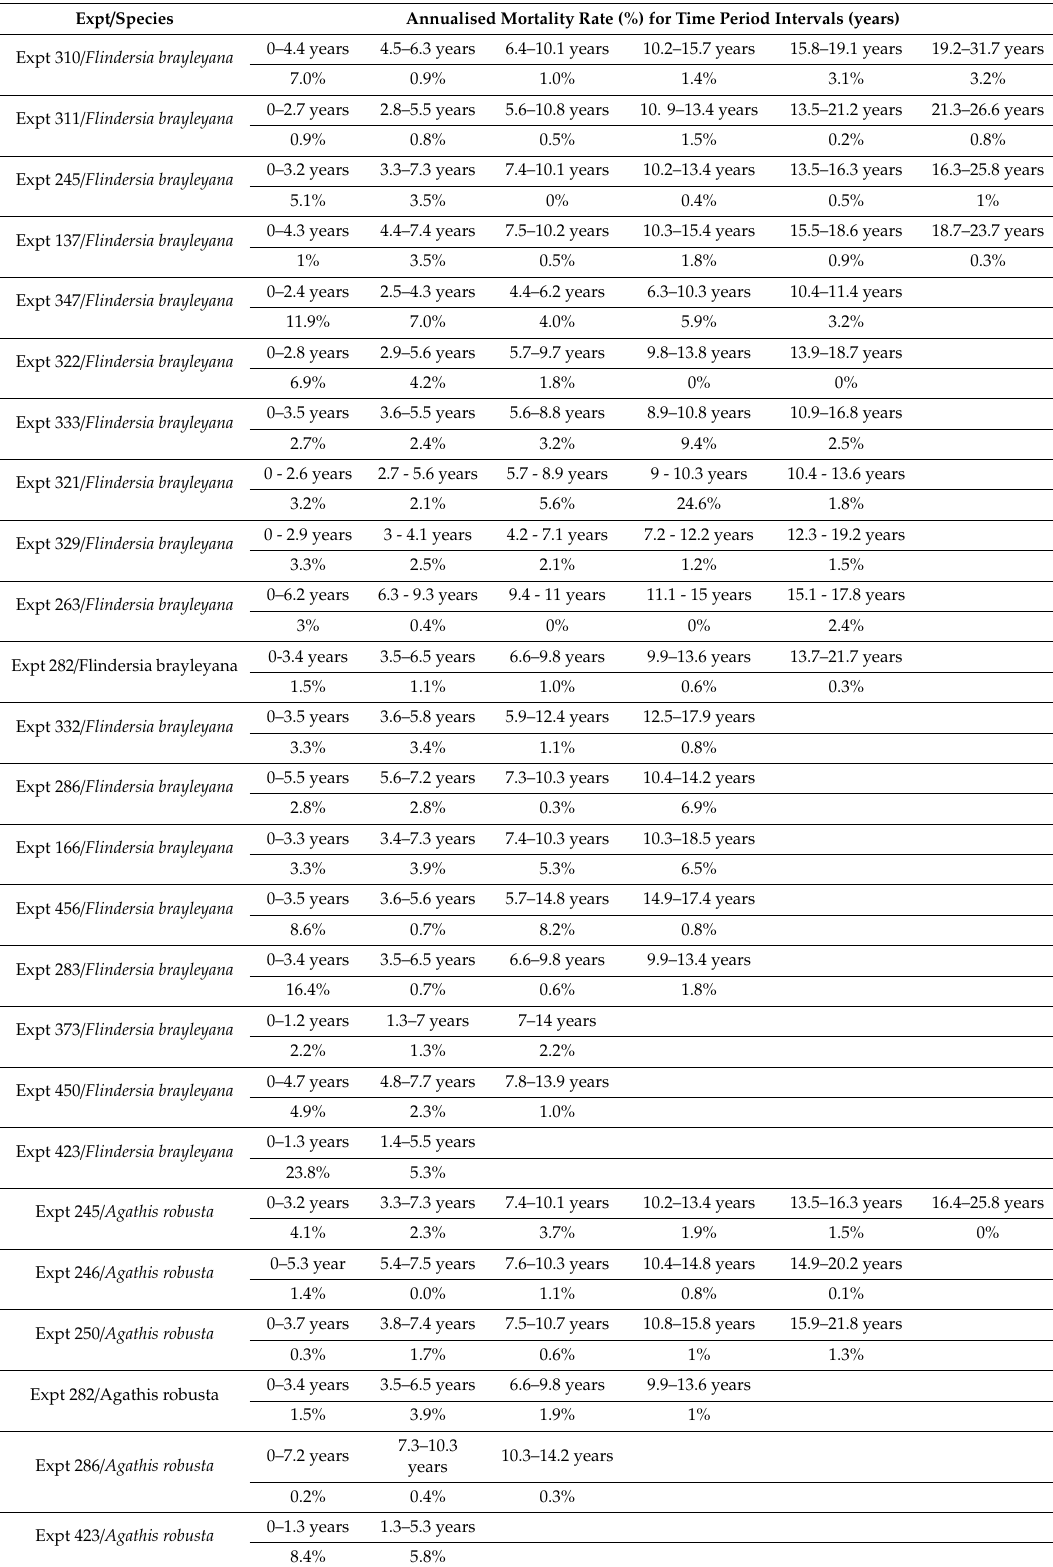
Table A3. Annualised mortality rate of enrichment plantings over di ff erent periods between measurements